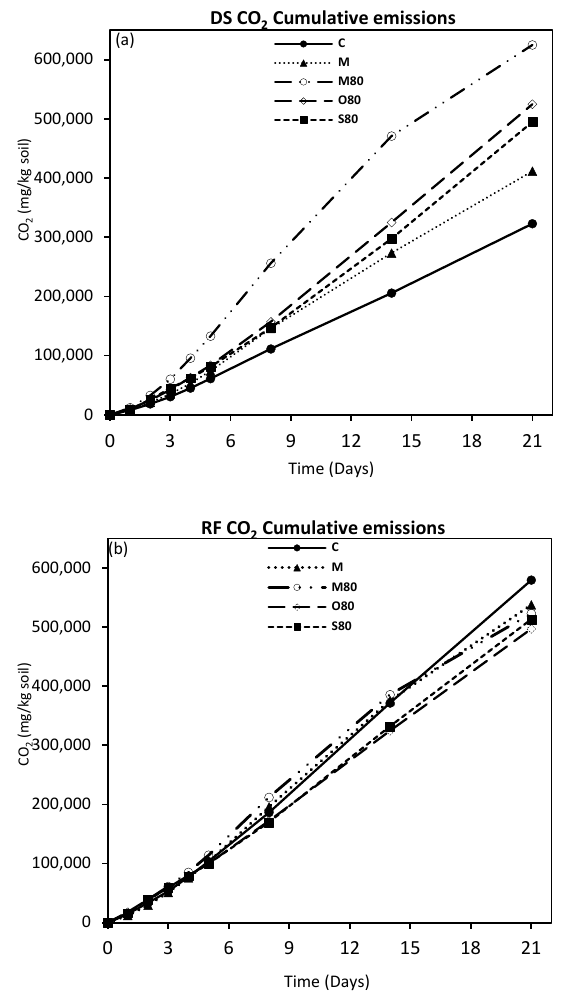
Figure 5. Cumulative CO 2 emissions from four cropping treatments on ( a ) Dry Savanna, DS , and ( b ) Rainforest, RF , soils. C = control, M = manure treatment, M80 = Manure + 80 kg N/ha, O80 = No manure + 80 kg N/ha S80 = soil pot microdosed with 80 kg N/ha without any vegetables.